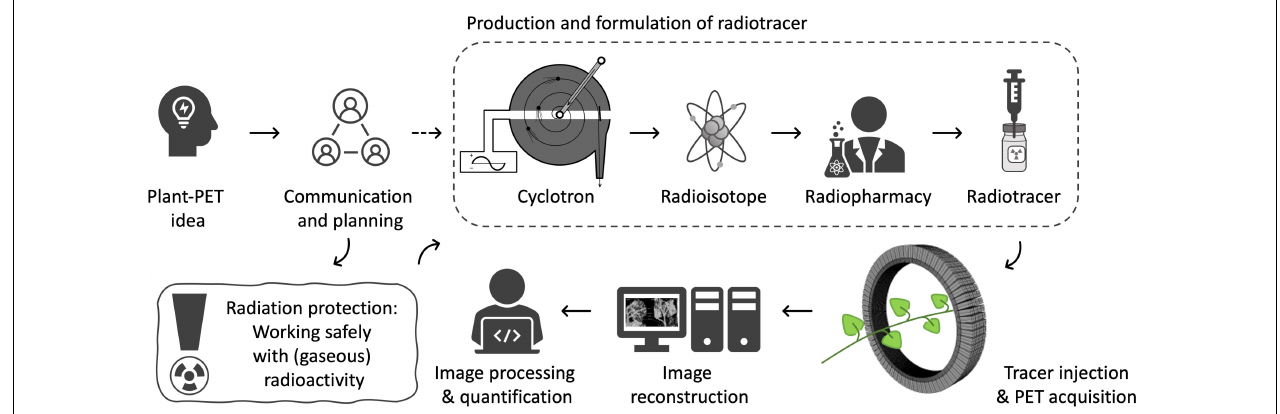
FIGURE 2 | Schematic showing the multidisciplinary steps in performing PET experiments on